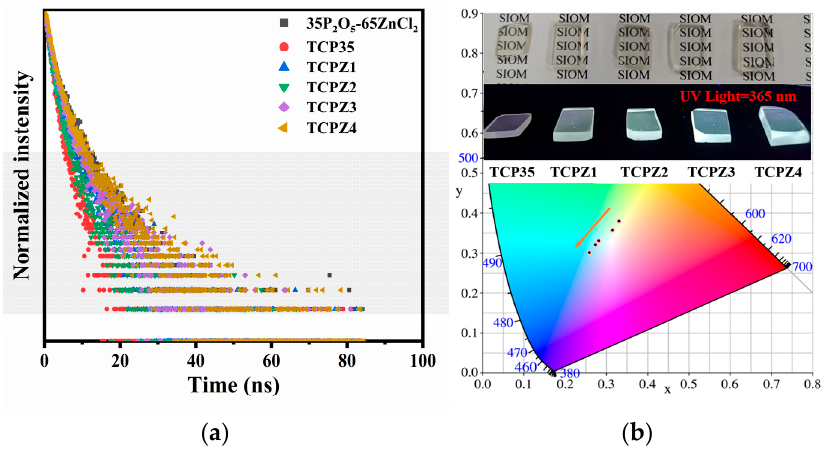
Figure 6. ( a ) Fluorescence decay curve of TCPZ glasses at 530 nm; ( b ) Color coordinates of the TCPZ glasses and photograph of the physical samples and luminescence under UV lamp excitation.